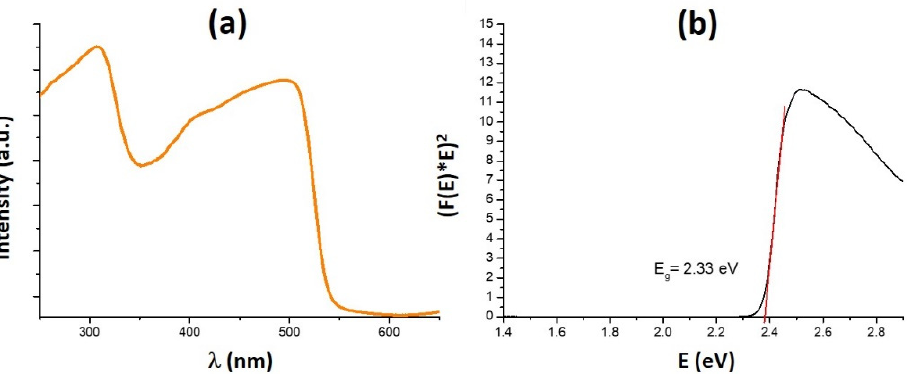
Figure 3. Absorption spectrum of a crystallized powder of (HPA) 6 (MA)Pb 5 I 17 ( a ) and corresponding Tauc plot (black curve) assuming a direct band gap (( b ), red line: fitted line giving